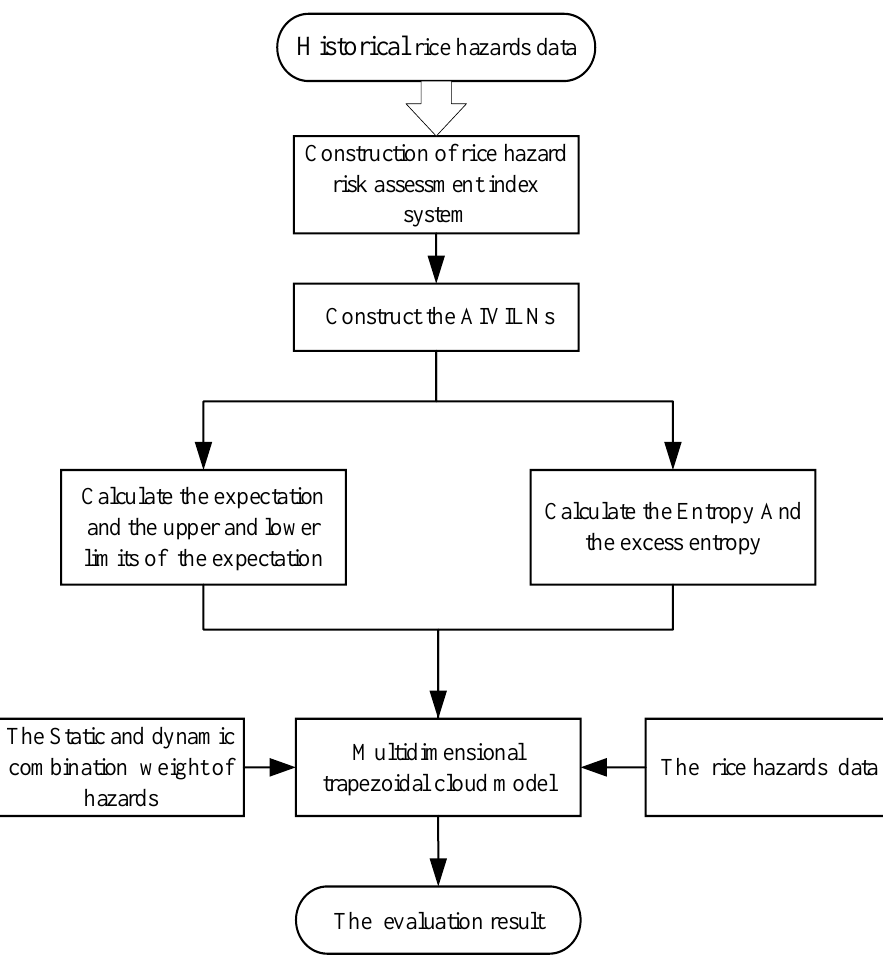
Figure 1. Proposed method flowchart.